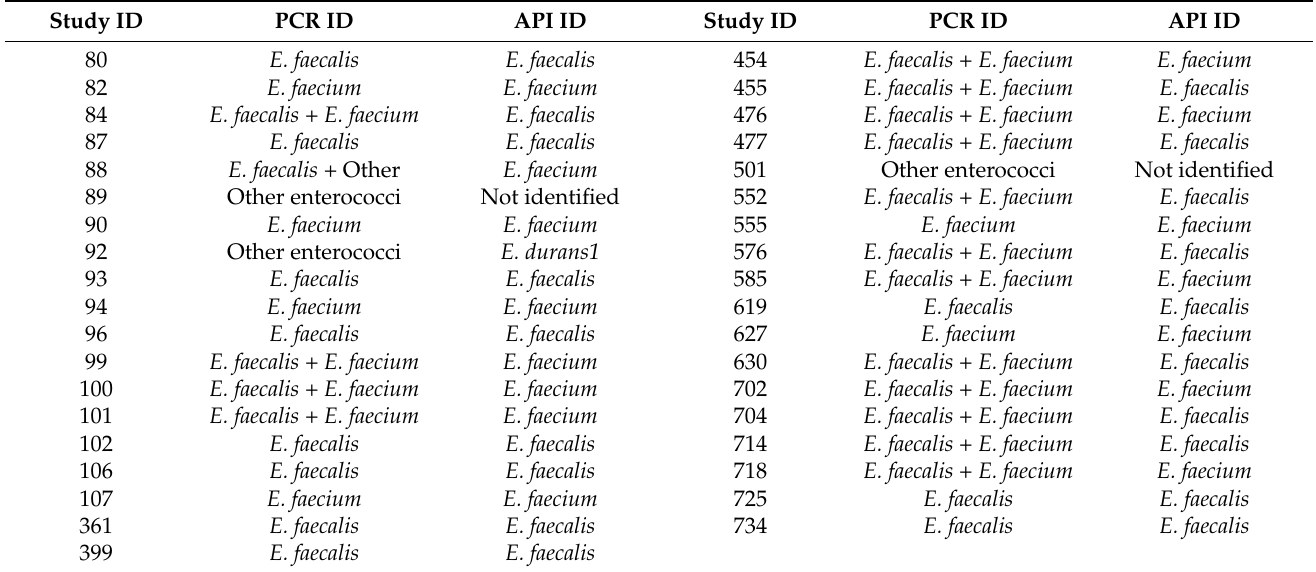
Table 1. API and PCR Identities.